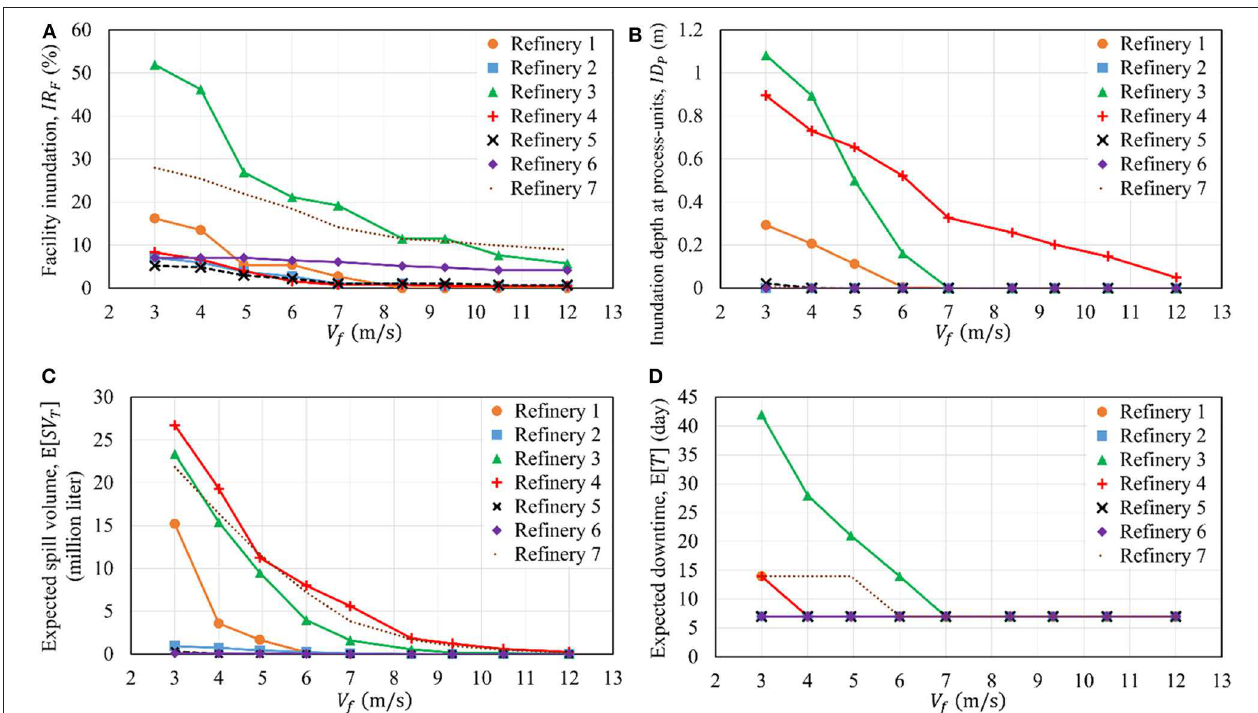
FIGURE 7 | Effect of forward speed of FEMA 33 (SLR = 0cm) on the intermediate parameters used in the loss analysis. (A) Facility inundation, (B) Process-units inundation, (C) Spill volume, (D) Refinery downtime.